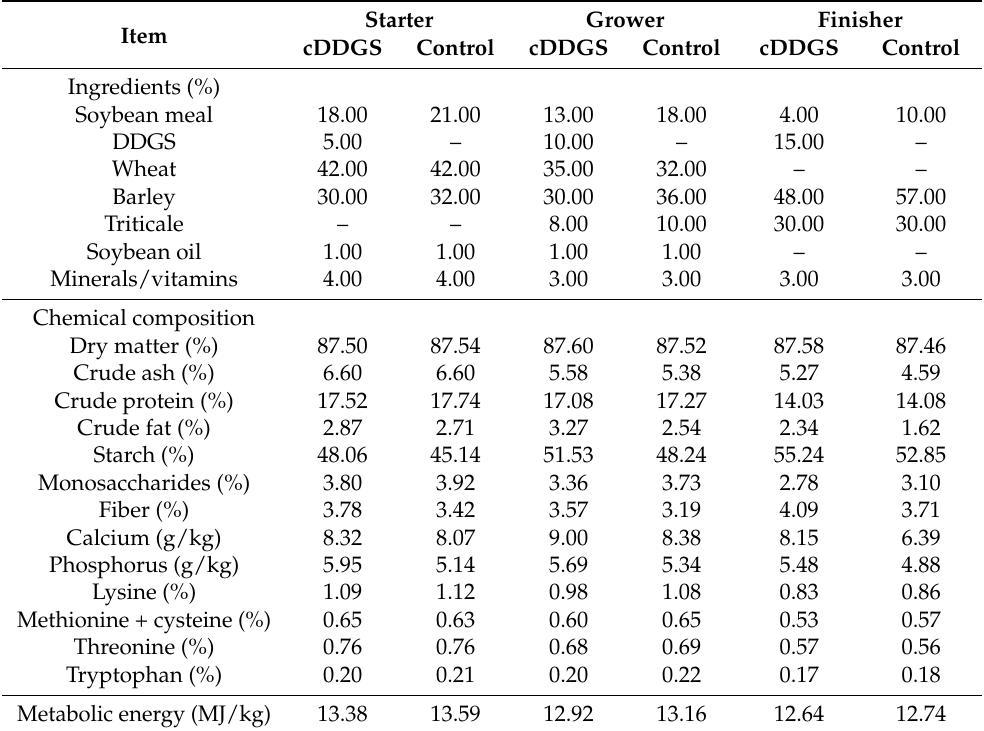
Table 2. Main ingredients, chemical composition, and metabolic energy of the experimental (SBM + cDDGS) and control